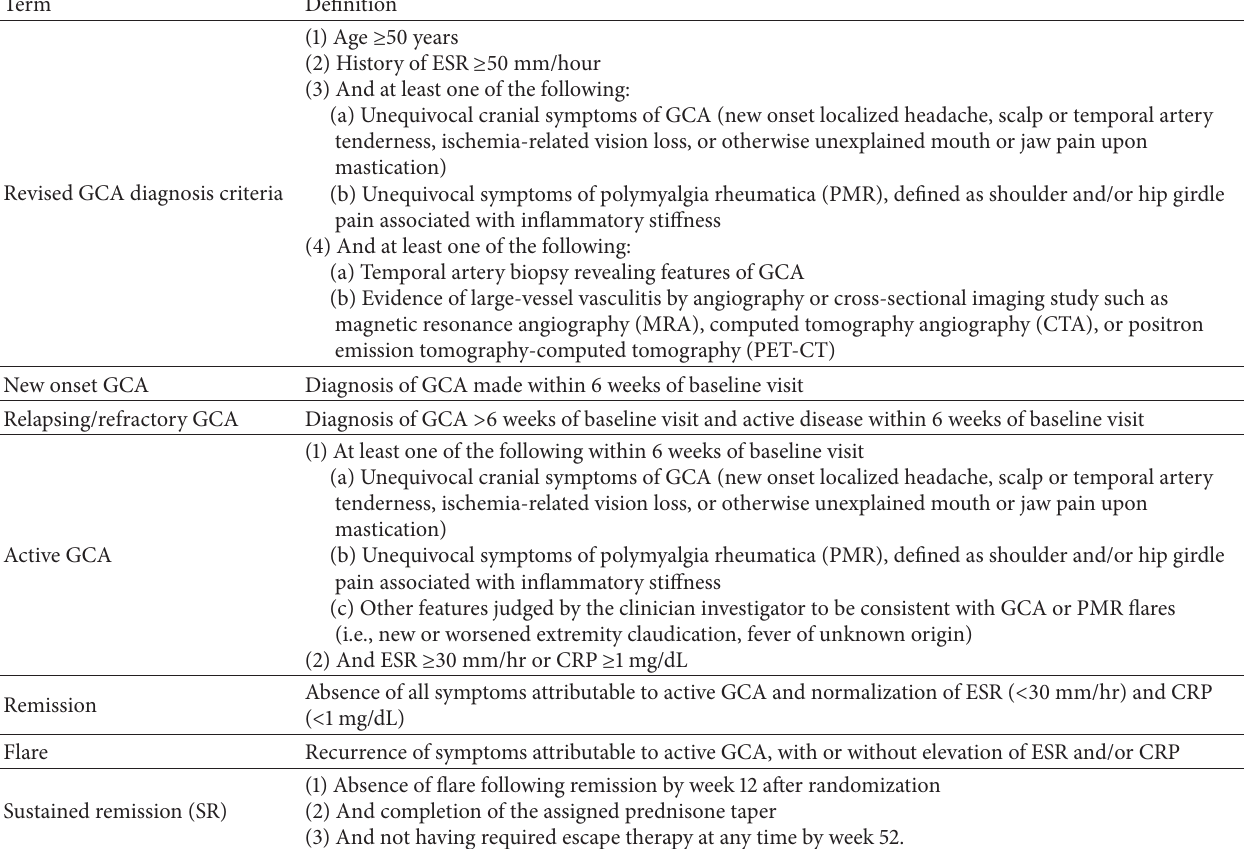
Table 1: Critical trial